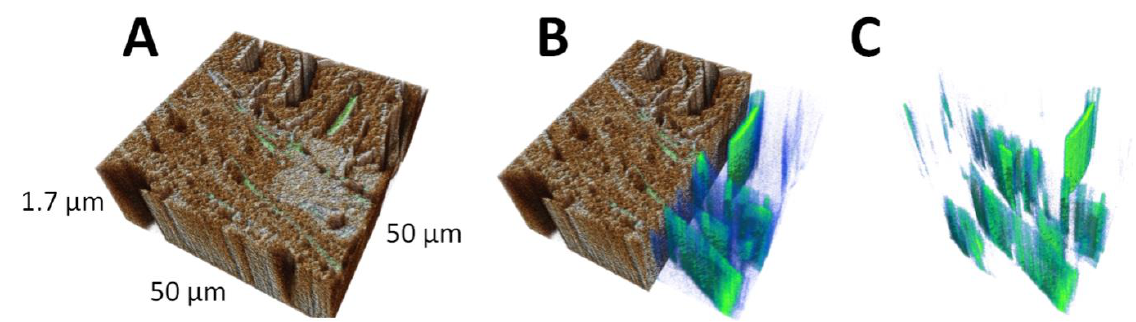
Figure 6. 3D-visualisation of the spruce particle–particle bondlines, using TOF SIMS data, reconstructed by the ORS software (Object Research Systems, Montreal, QC, Canada); ( A , B ) spruce PB with visible particle–particle bondline, ( C ) pMDI bondline imaging (Q/m 26).